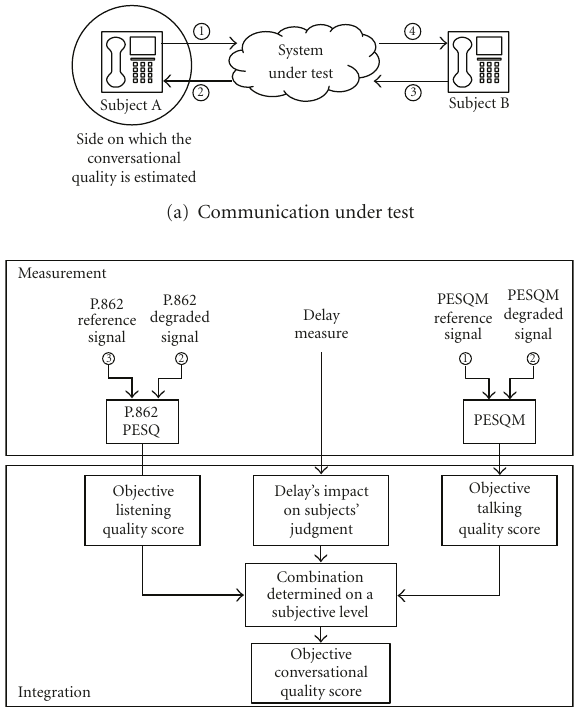
Figure 4: Scheme of the proposed objective model of the conversa- tional